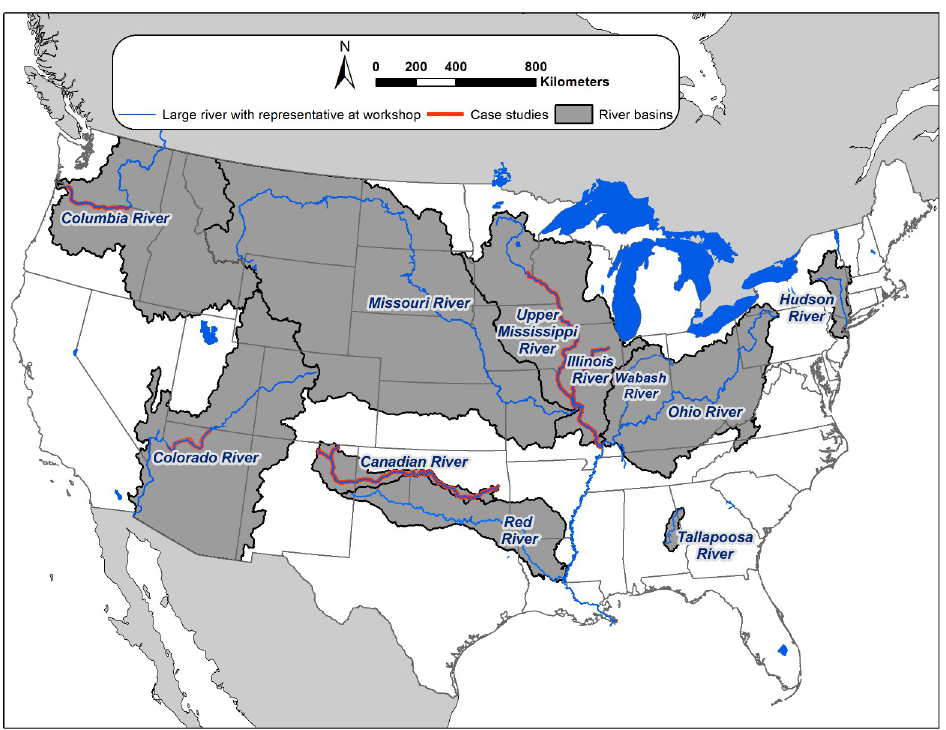
Fig 1. Map of rivers and watersheds represented by scientists that convened to develop a conceptual model that depicts how natural and anthropogenic drivers interact with habitats, biological systems, and fish in large rivers. River segments where we conducted case studies that applied the conceptual model to identify monitoring information needs associated with management goals are highlighted in red. Data used: 1:2,000,000-Scale Hydrologic Unit Boundaries–source: U.S. Geological Survey; U.S. States (Generalized), U.S. Rivers (Generalized) 2005, U.S. Lakes (Generalized) 2005, and World Countries 2005 –source: